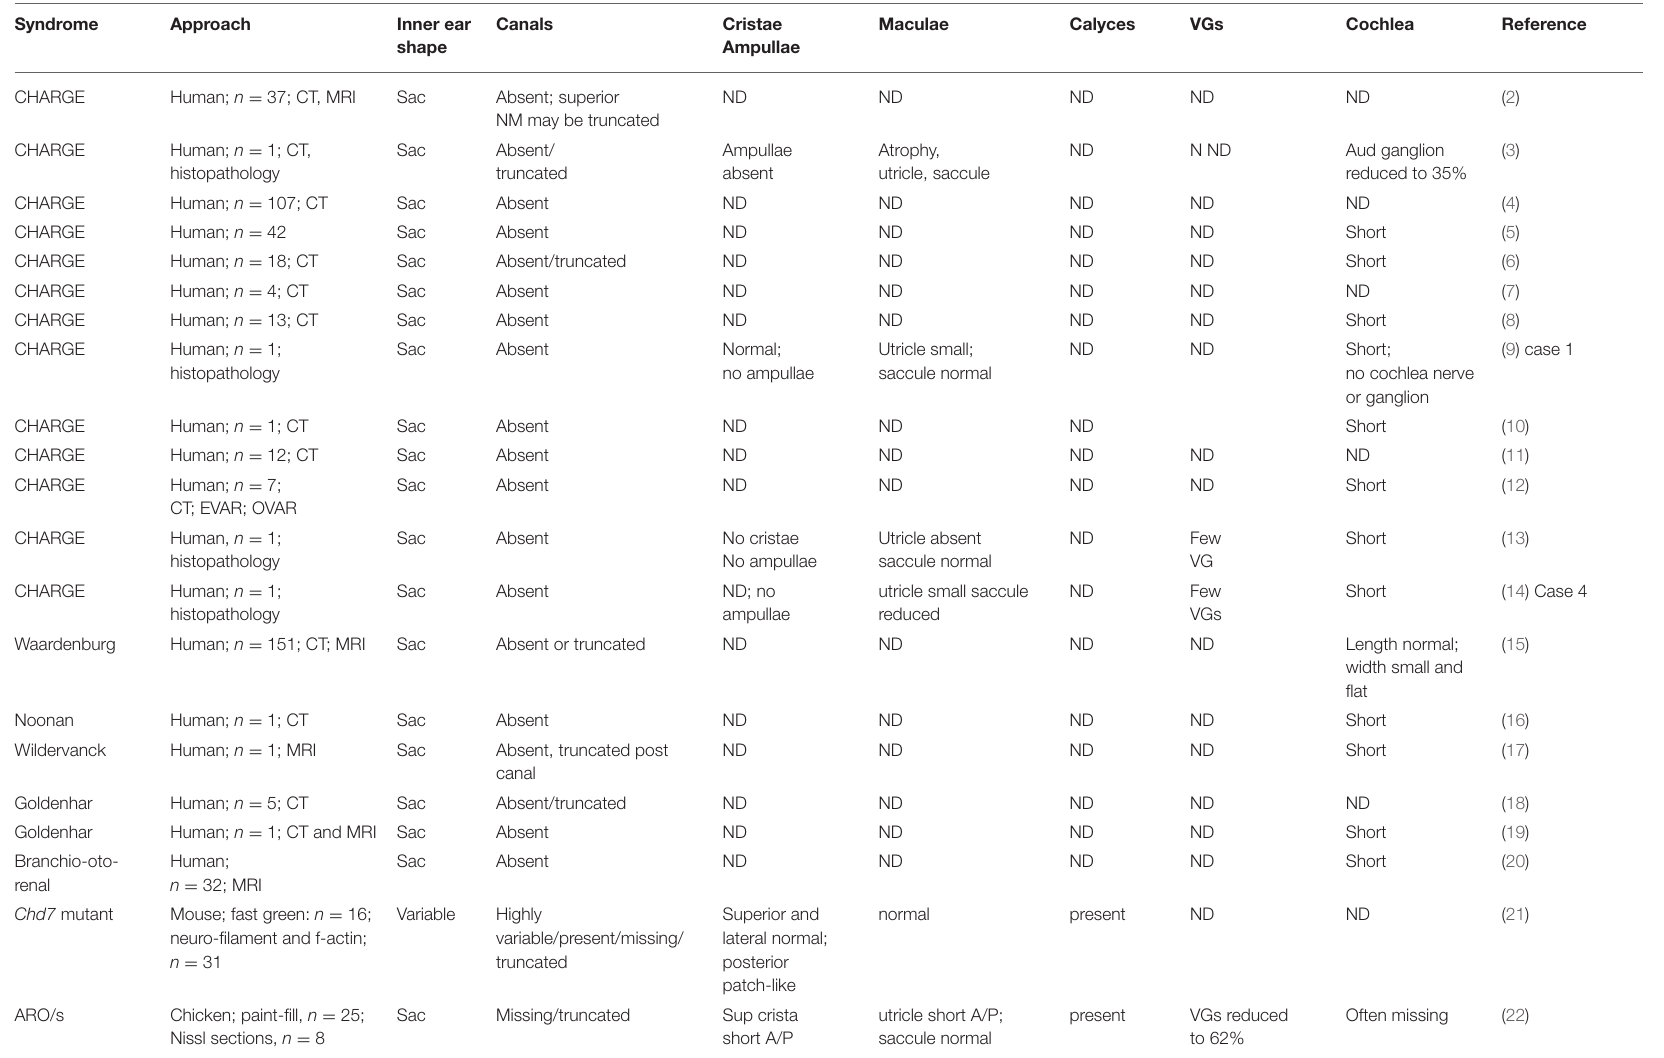
TABLE 1 | Sac-like phenotype in human congenital vestibular disorders and animal models.